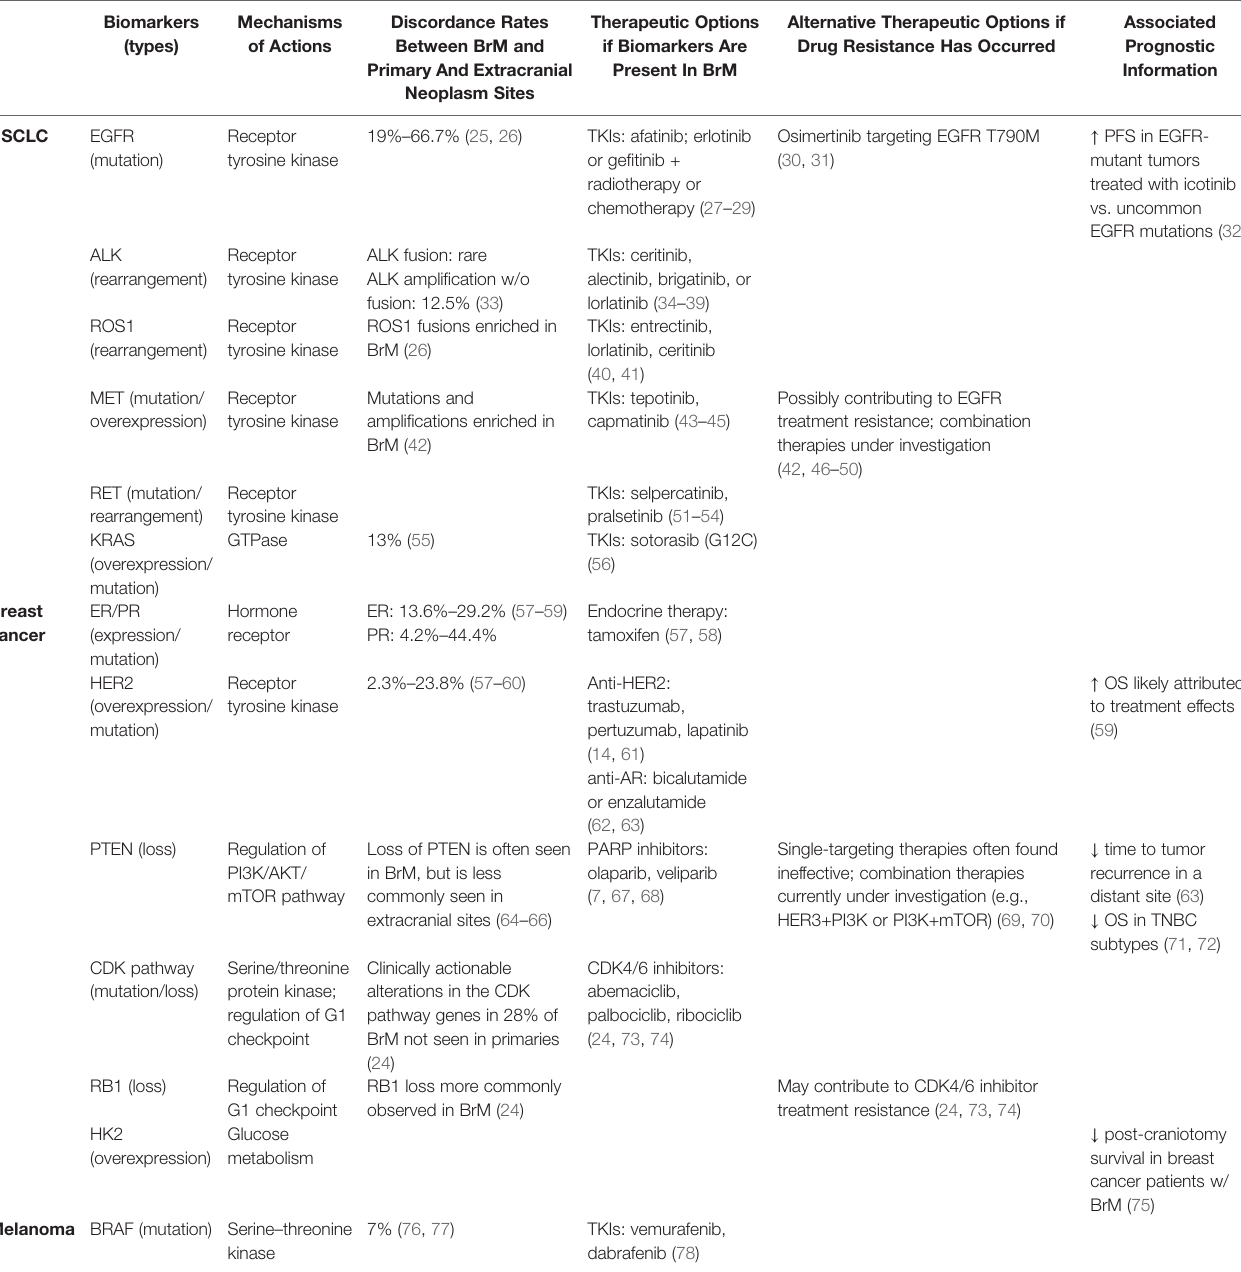
TABLE 1 | Summary of therapeutic possibilities and prognostic information associated with biomarkers in brain